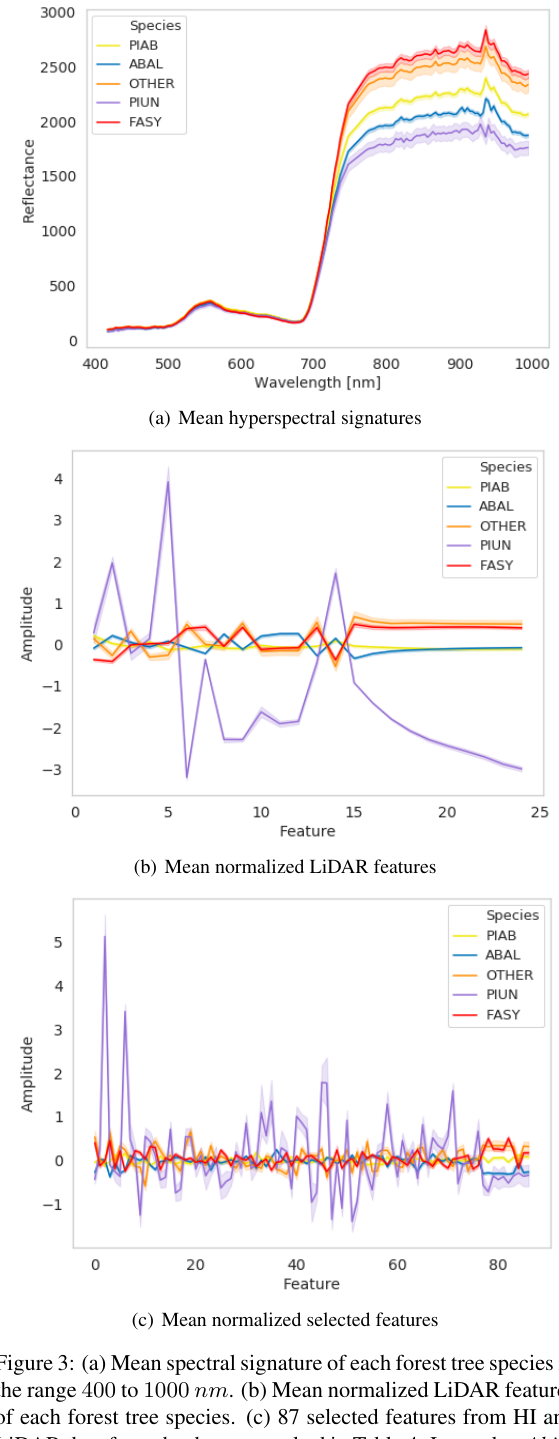
Figure 3: (a) Mean spectral signature of each forest tree species in the range 400 to 1000 nm . (b) Mean normalized LiDAR features of each forest tree species. (c) 87 selected features from HI and LiDAR data from the datasets ranked in Table 4. Legend: Abies alba (ABAL), Fagus sylvatica (FASY), Picea abies (PIAB), Pinus uncinata (PIUN) and “other” species